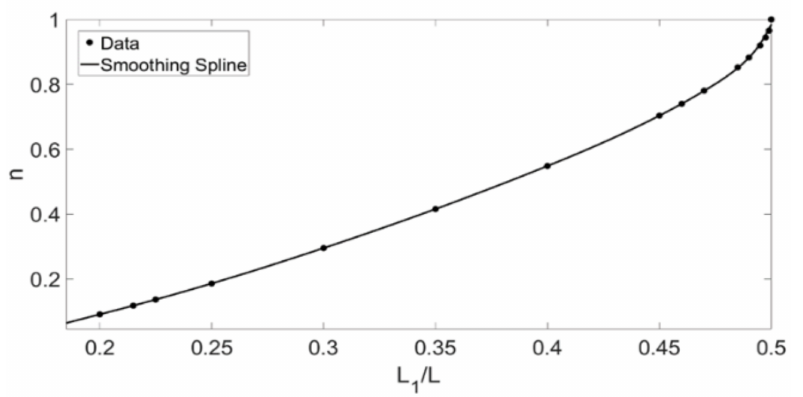
Figure 5. Fractional differentiation order n as a function of the relative grating length L 1 / L